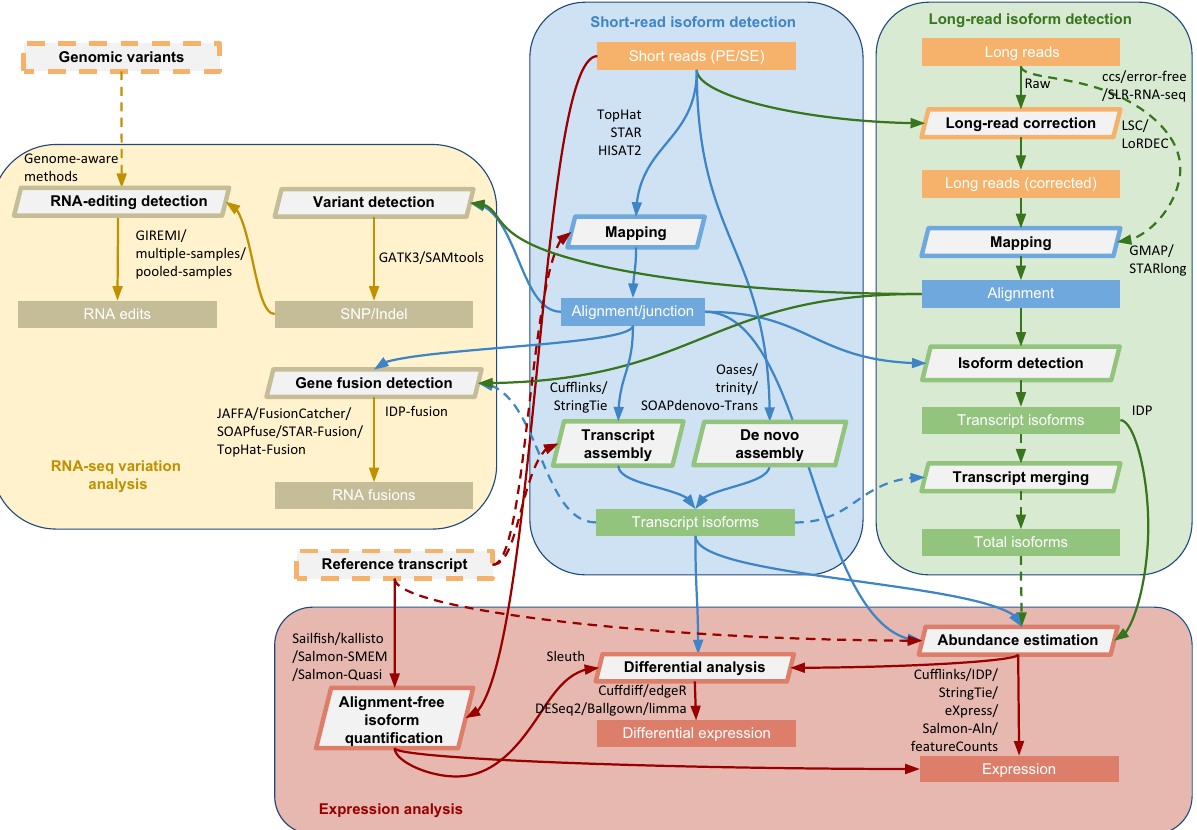
Fig. 1 The RNACocktail analysis protocol. RNACocktail is a comprehensive protocol of RNA-seq data analysis. The fi gure summarizes the widely used approaches for the key steps over the broad spectrum of RNA-seq analysis and also succinctly captures the possible work fl ows one can use to analyse RNA-seq